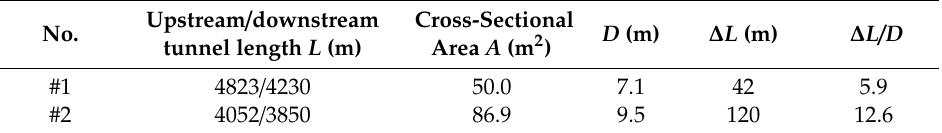
Table 1. Test condition of the consecutive tunnels.